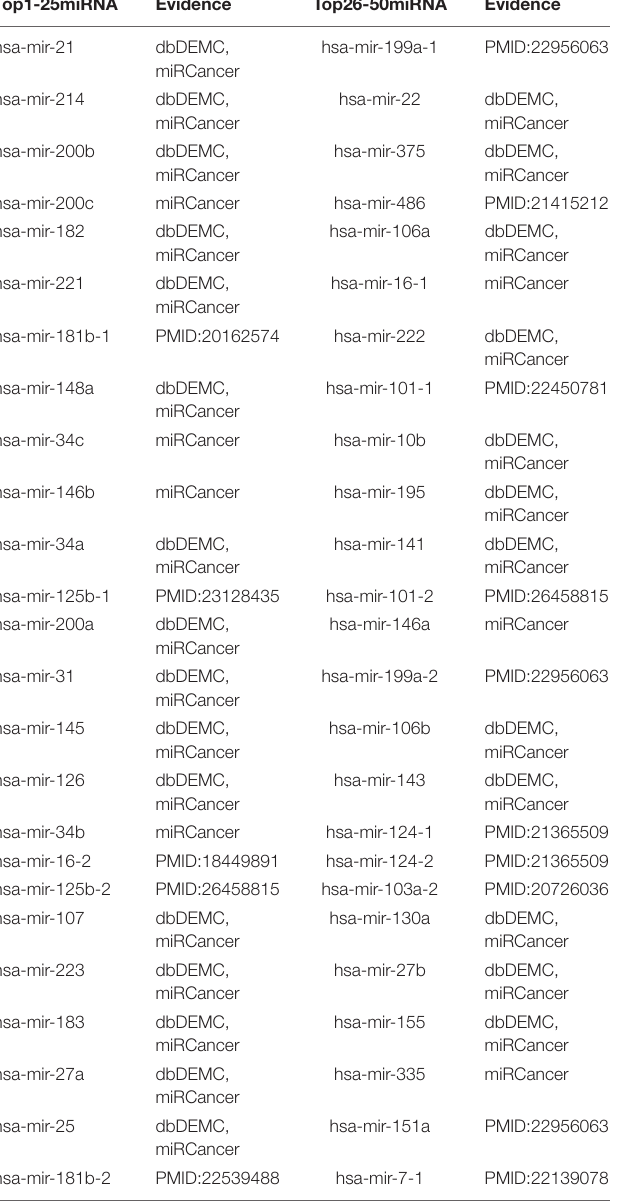
TABLE 5 | Top 50 Related miRNAs of Stomach Neoplasms predicted by MDN-NMTF on HMDD2.0-Yan Dataset. Top1-25miRNA Evidence Top26-50miRNA